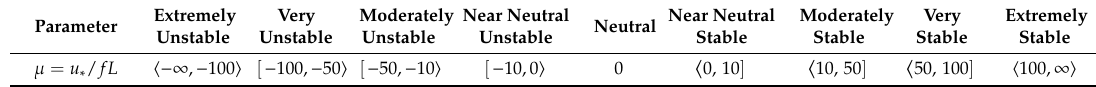
Table 2. Stability classes, as suggested by Arya [17]. Sonic at z = 12